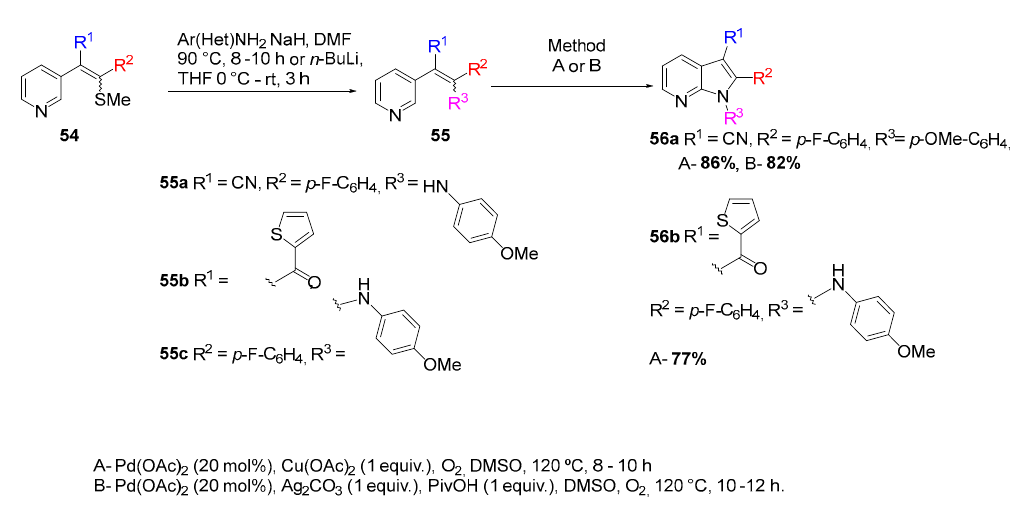
Scheme 23 . Synthesis of 7-azaindole core from 2,3-(het)aryl-3- N -aryl/acylenaminonitriles and